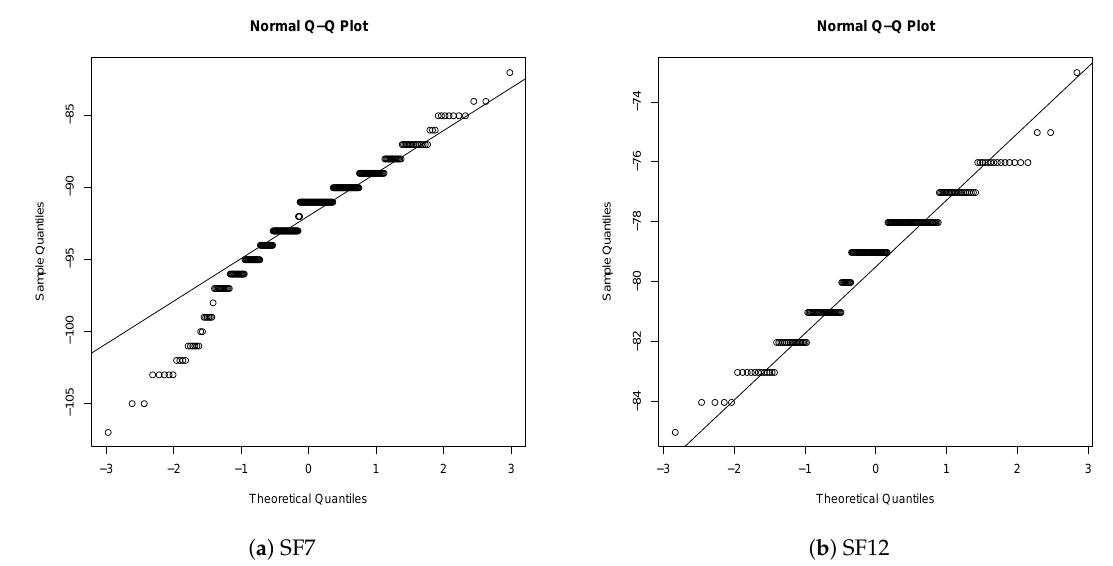
Figure 10. Q-Q plot of the RSSI with two different spreading factors at 50